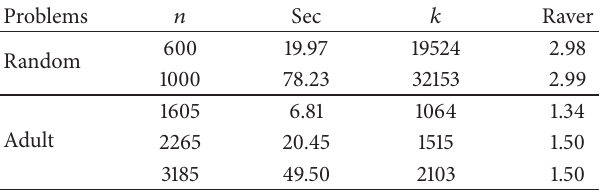
Table 1: Numerical results for Algorithm 3. Problems